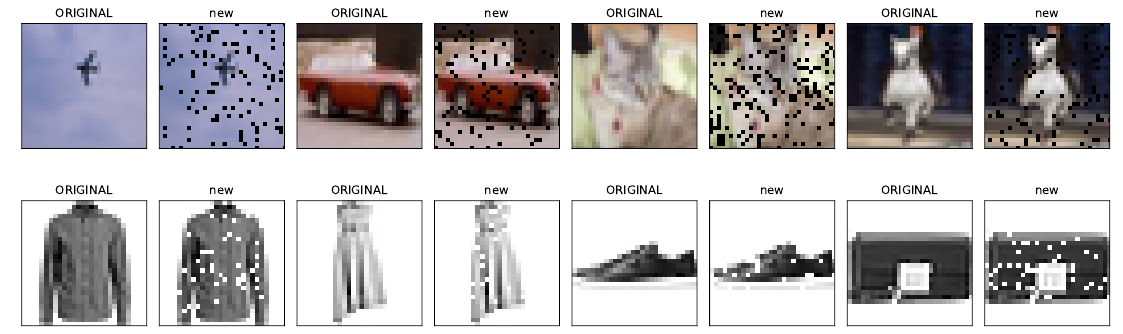
Figure 15. Examples from new CIFAR-10 (top) and Fashion-MNIST (bottom) test sets with missing pixel